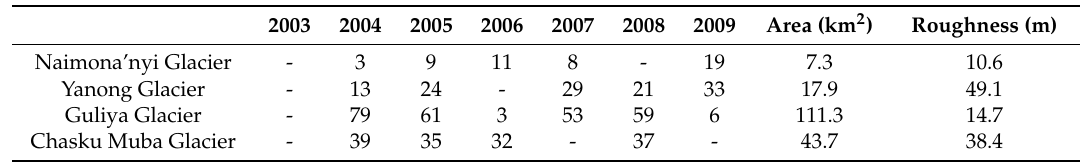
Table 1. Area, roughness, and number of footprints acquired in the four glaciers. “-“ : No GLAS